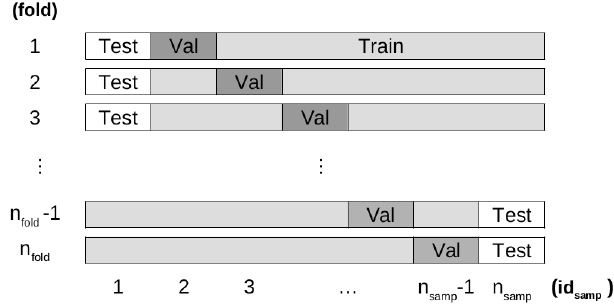
Figure 2. Folding strategy for the LTO procedure with n fold = n samp × (n samp − 1 ) folds (corresponding to the n fold rows). In each fold, there are one testing, one validation, and ( n samp − 2) training